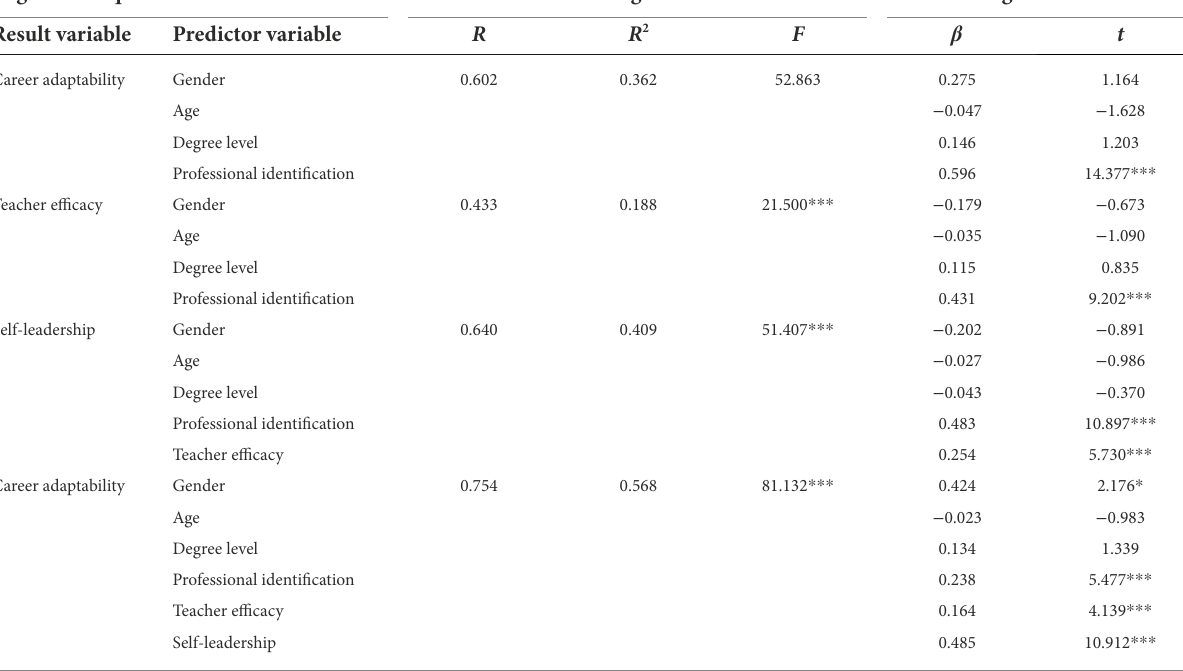
TABLE 2 Regression analysis of the relationship between professional identification and career adaptability. Regression